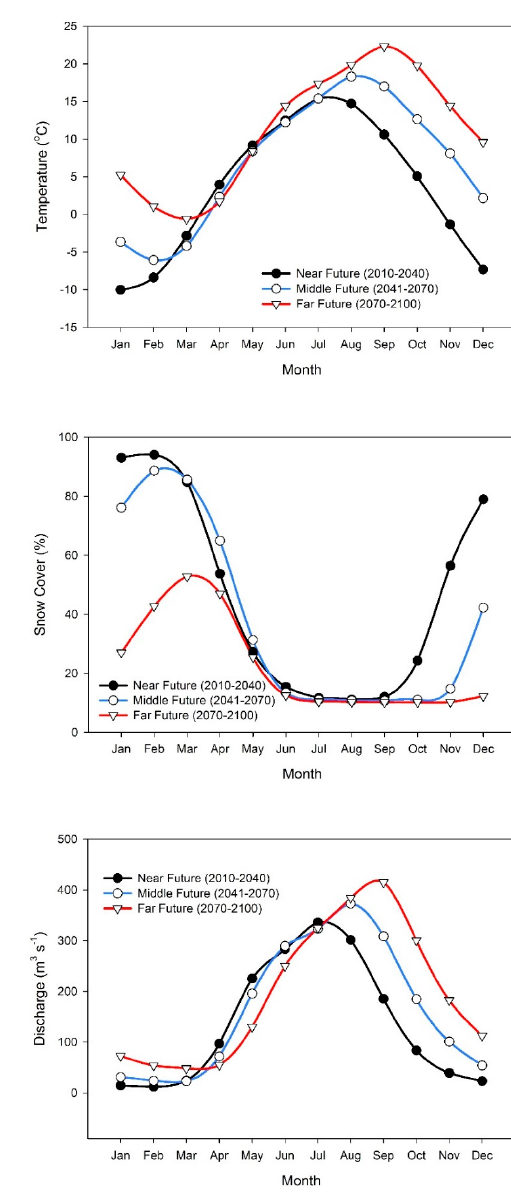
Figure 14. Monthly projected average temperature, snow cover and discharge for near (2010–2040), middle (2041–2070) and future (2070–2100) RCP4.5; and RCP8.5 climate change scenarios for the Astore River at the Dayan.